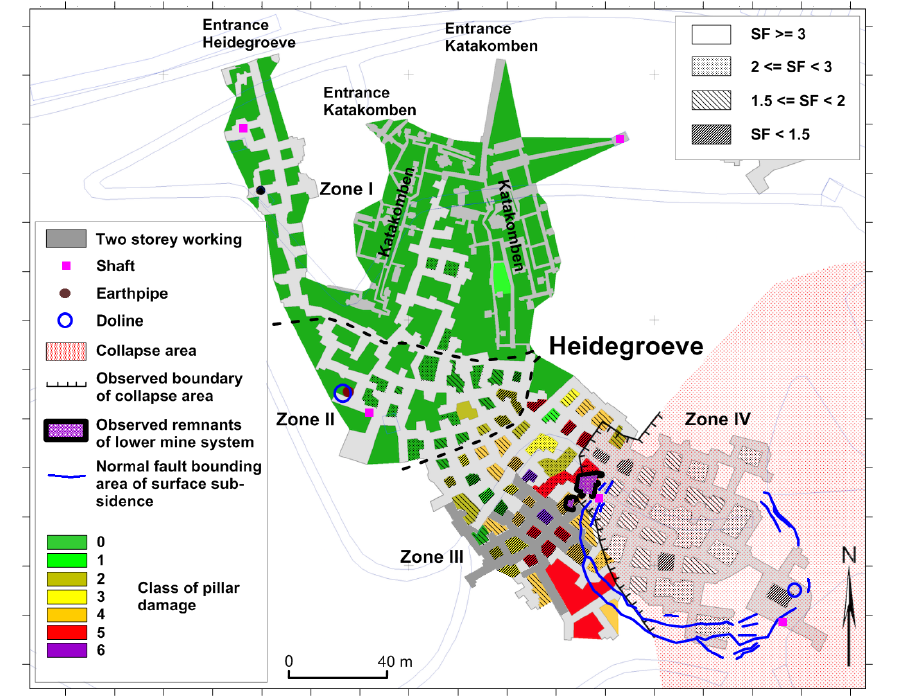
Figure 2. Map of the